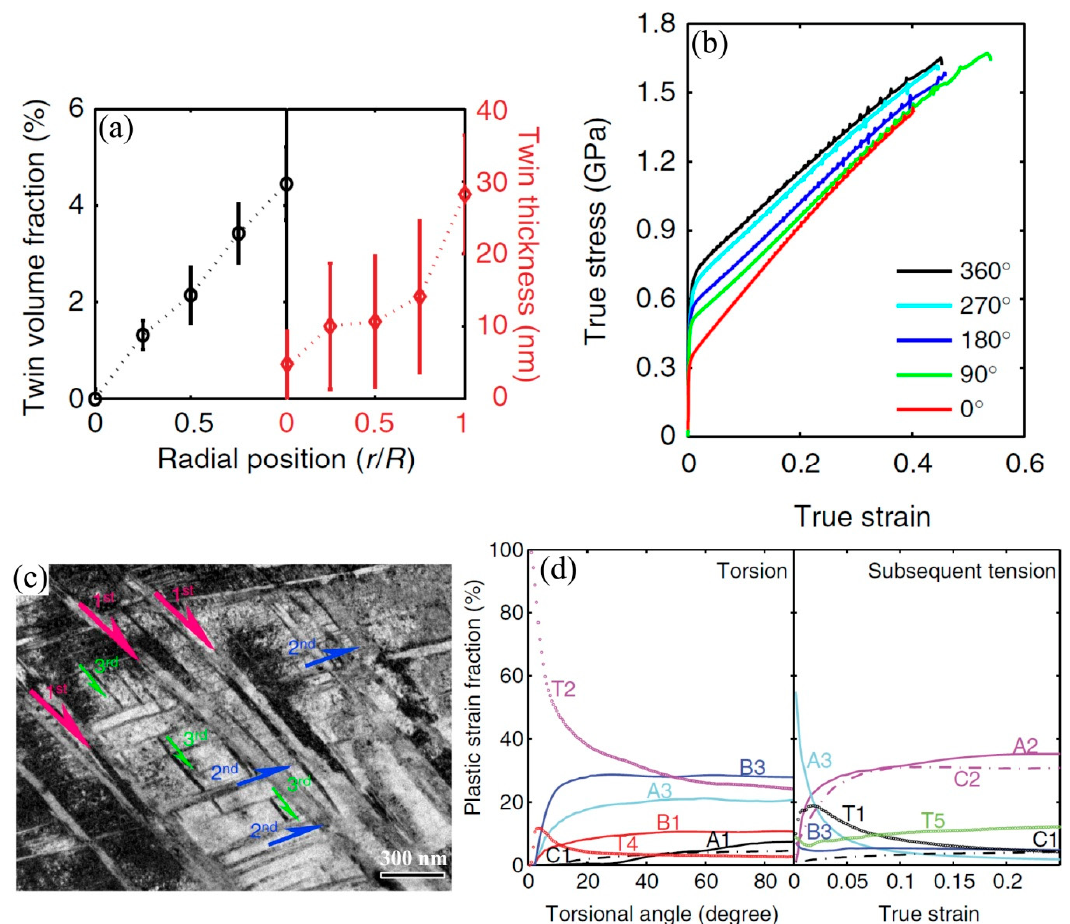
Figure 7. Tensile properties and corresponding deformation mechanisms of a TWIP steel with gradient twinned structure: ( a ) Twin volume fraction and twin thickness distributions along the radial direction; ( b ) True stress–strain curves; ( c ) Hierarchical twin structures formed during the pre-torsion deformation and the subsequent tensile loading; ( d ) Activated different twinning systems in the sequential torsion and tension deformation. Adapted from [47].